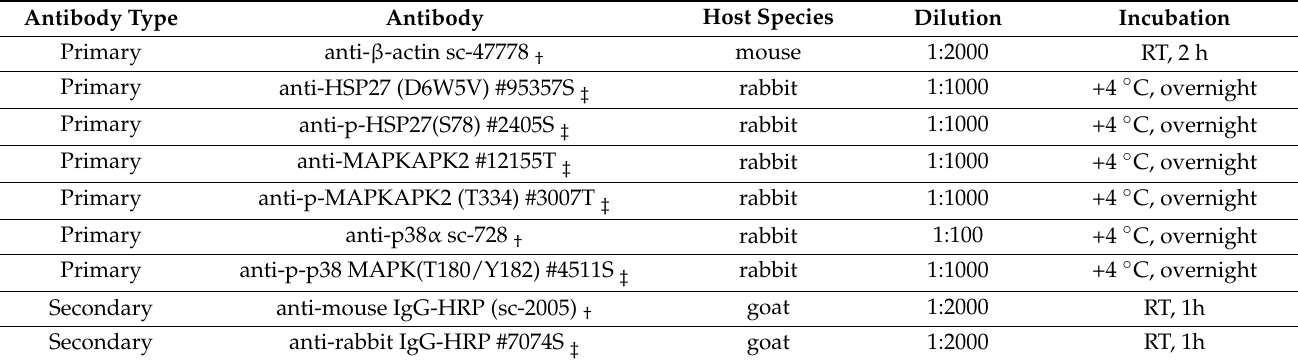
Table 1. Primary and secondary antibodies used in